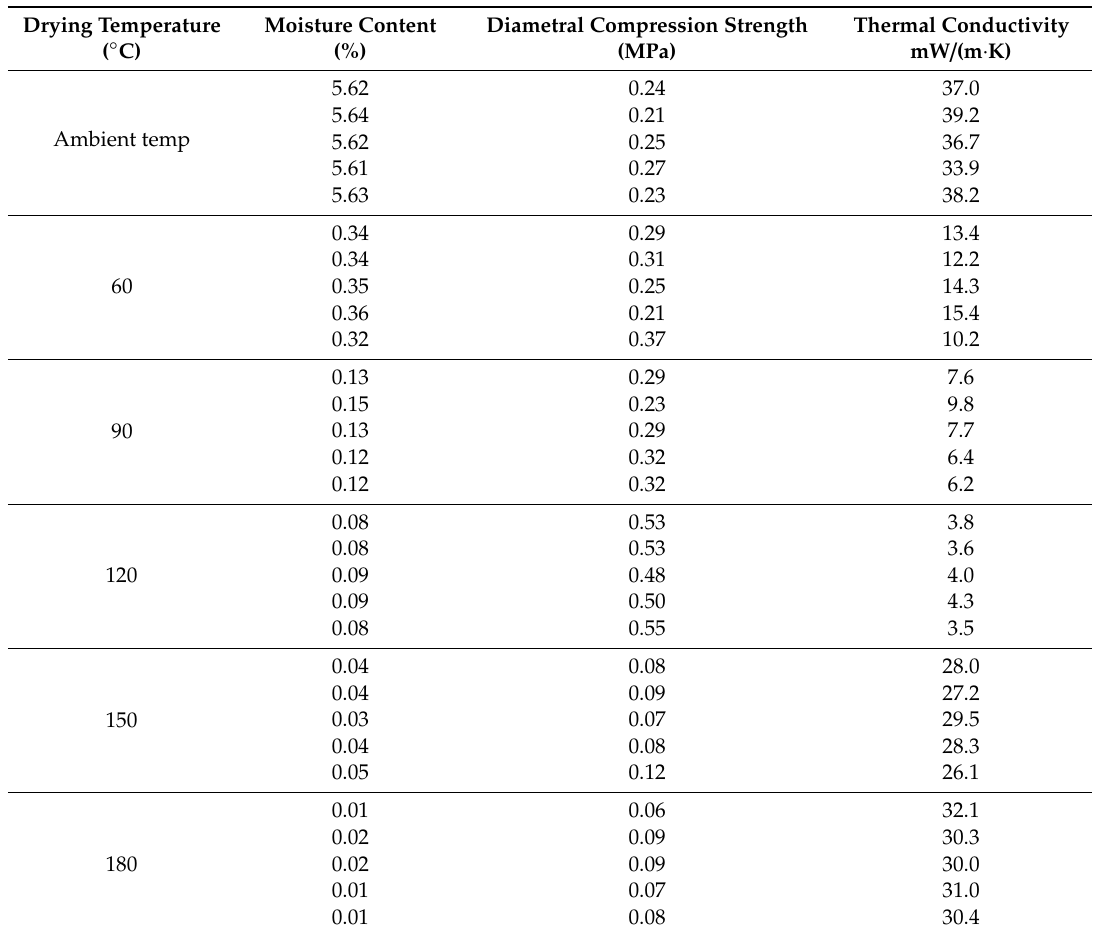
Table 2. Various properties at di ff erent drying temperature.